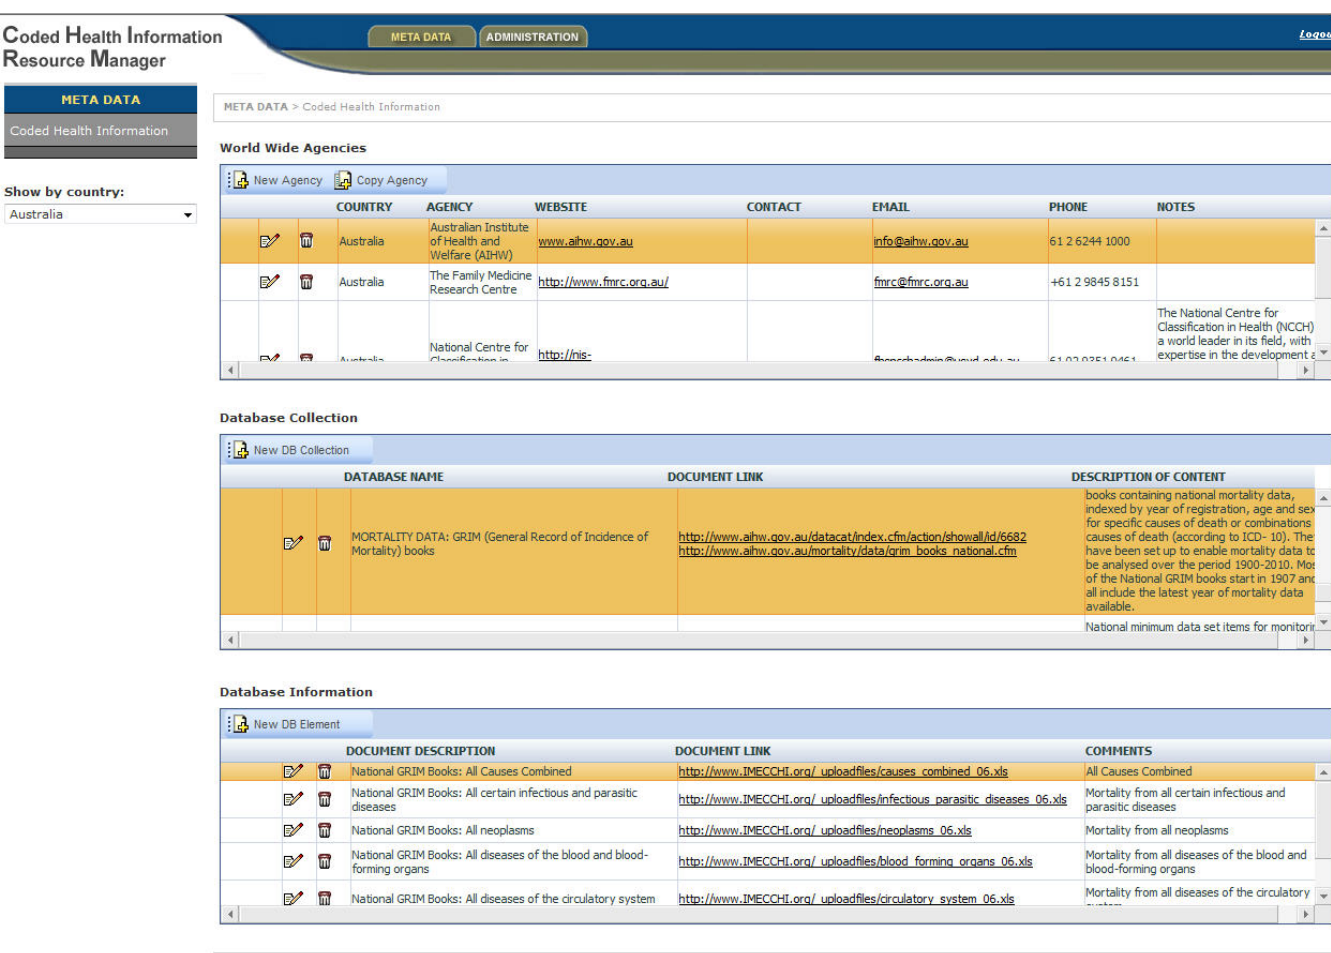
Figure 1: Screenshot of Global Health Meta-data